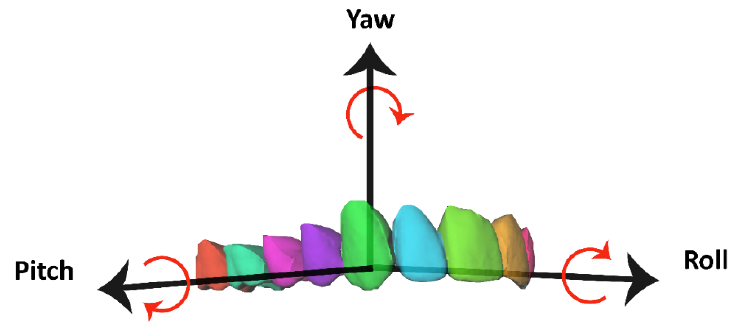
Figure 2. Teeth can move around three rotation axes—yaw, roll, and pitch—as shown in an upper dental arch.